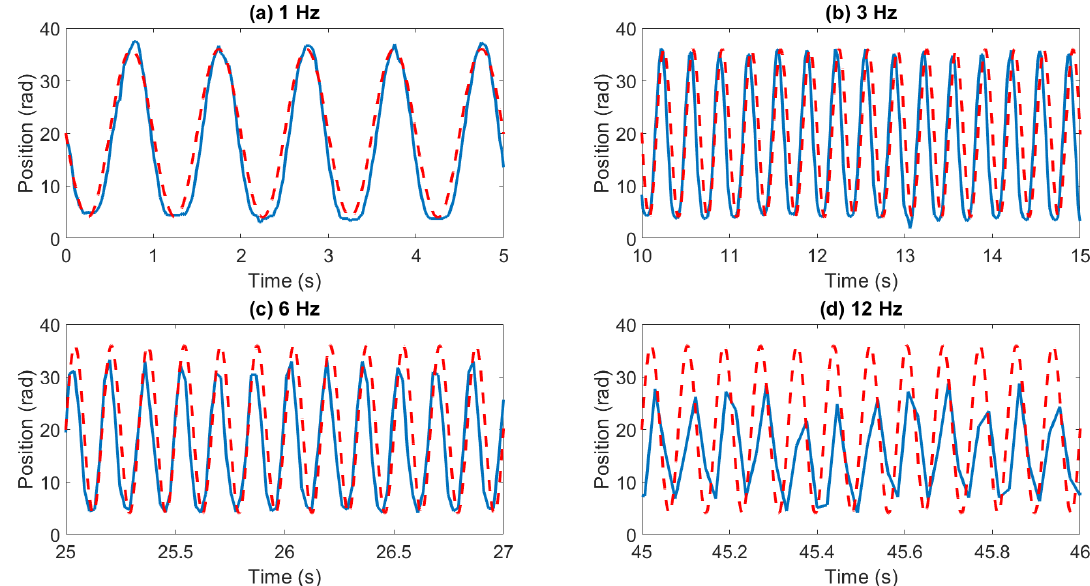
Figure 5. Sensor response (blue line) to sinusoidal input (red line) at ( a ) 1 Hz, ( b ) 3 Hz, ( c ) 6 Hz and ( d ) 12 Hz. The red line shows the input and the blue line shows the sensor response. Table 1. Percentage drift over 1 min constant loading.